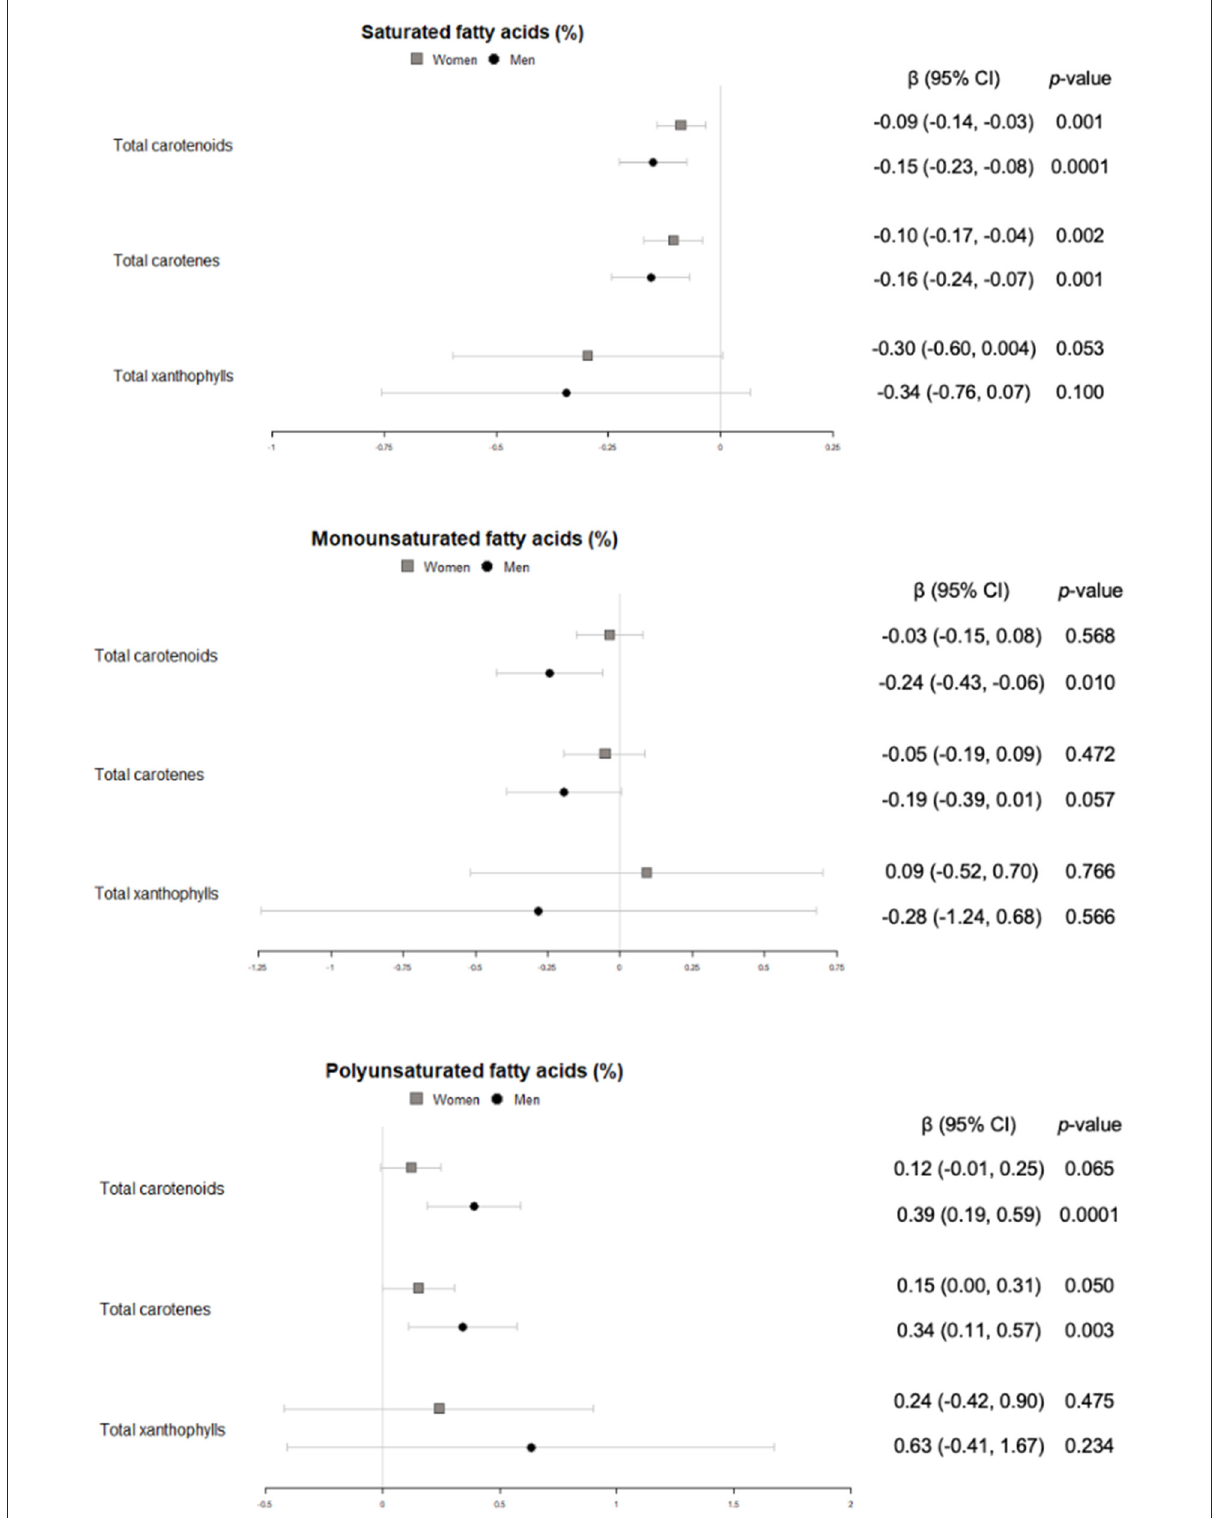
FIGURE8 Cross-sectional association of plasma carotenoids and subclasses (per unit increase) with plasma saturated, monounsaturated and polyunsaturated fatty acids (%) (95%-CI), and their respective p -values.